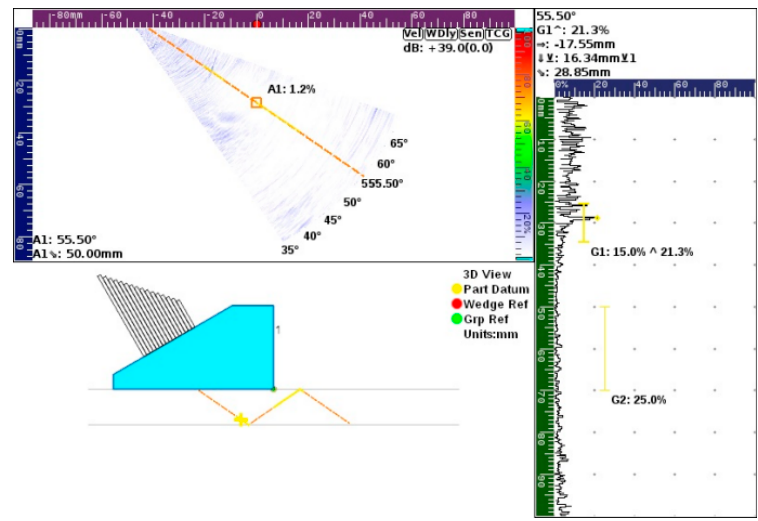
Figure 16. An example of a less confident signal return detected using PAUT.